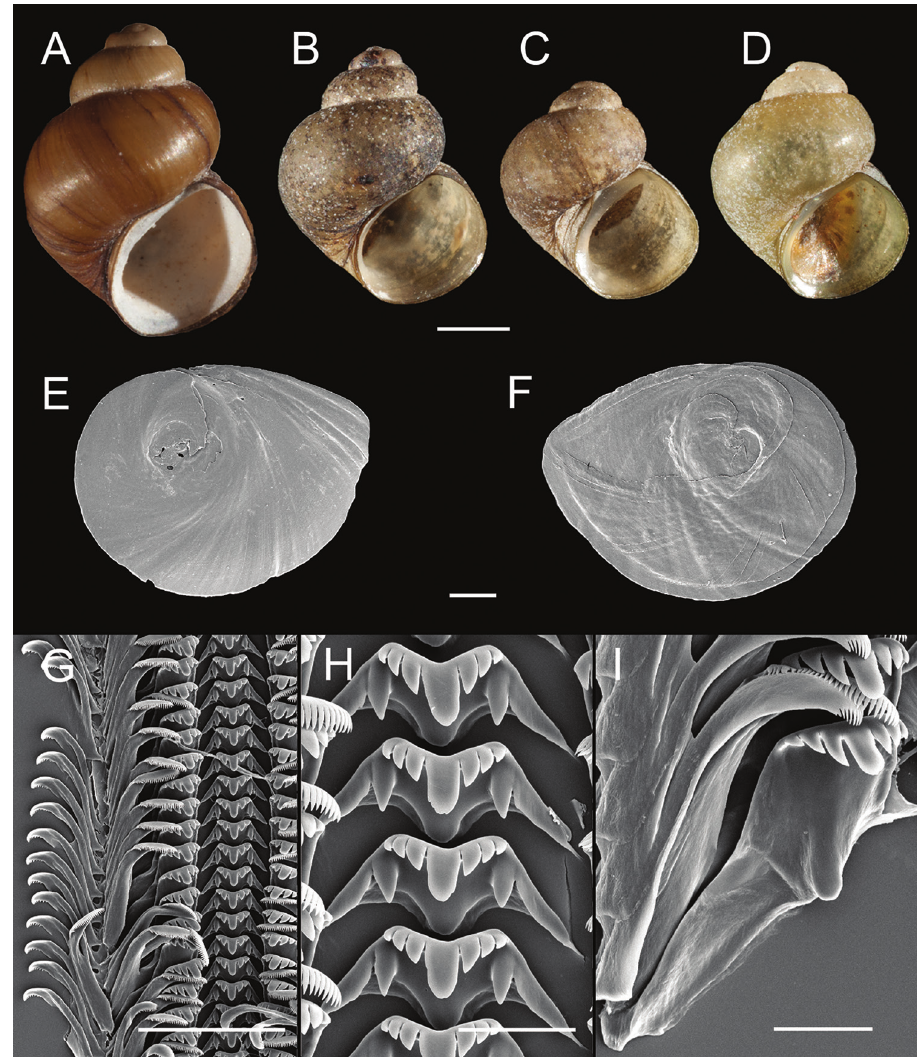
Figure 5. Shells, opercula and radula, F. fresti , sp. n. A Holotype, USNM 1144376 B, C Sympat- ric ovate-conic and trochiform shell morphs, respectively, USNM 1297149 D Shell, USNM 1297155 E, F Opercula (outer, inner sides), USNM 1422223 G Portion of radular ribbon, USNM 1422223 H Central teeth, USNM 1422223 I Lateral teeth, USNM 1422223. Scale bars: A–D 1.0 mm; E– F 250 µm; G 100 µm; H–I 20